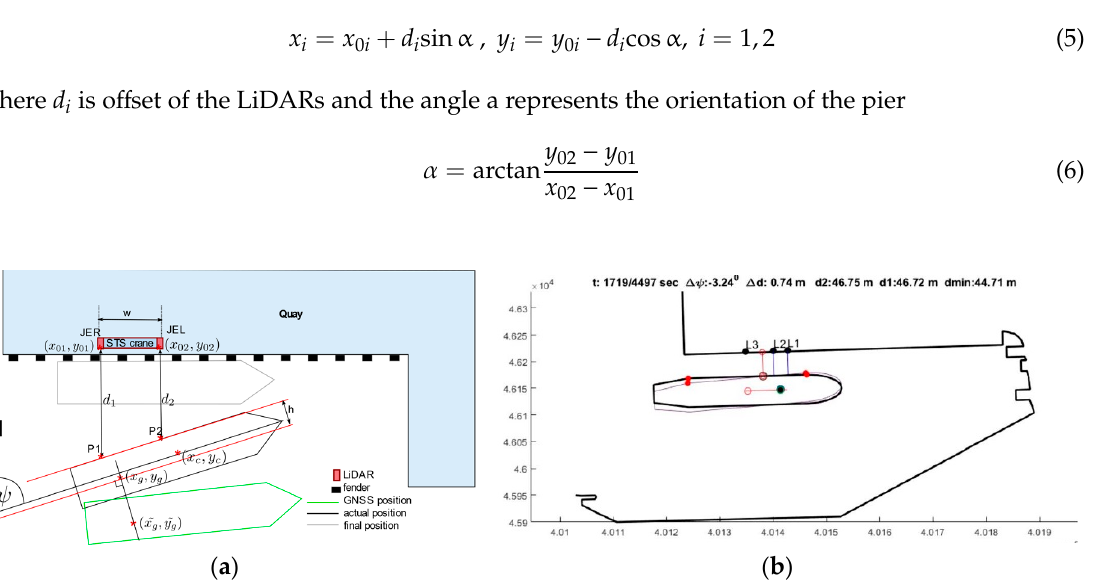
Figure 6. Fusion of GNSS and LiDAR measurements, model ( a ), final positioning ( b ). Table 7. Automatic Identification System (AIS) and global satellite-aided positioning system (GNSS) receiver features .